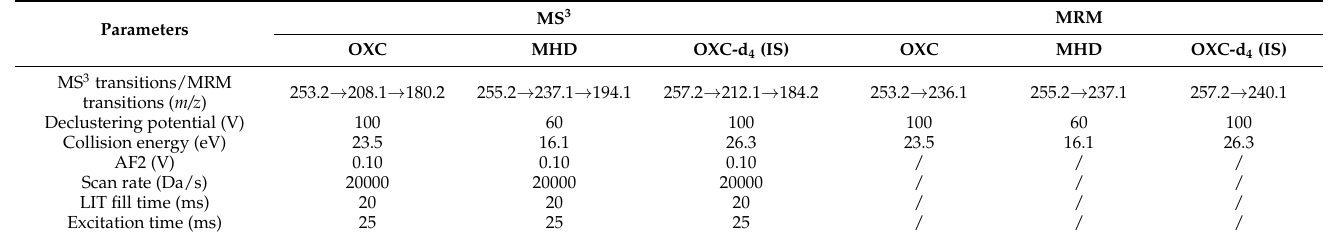
Figure 3. Product ion (MS 2 ) and second-generation product ion (MS 3 ) scans, respectively, for oxcarbazepine ( AI , AII ), 10-hydroxycarbazepine ( BI , BII ) and oxcarbazepine-d 4 ( CI , CII ). Table 4. Optimized parameters for the quantitation of oxcarbazepine (OXC) and 10-hydroxycarbazepine (MHD) using triple-stage fragmentation (MS 3 ) and multiple reaction monitoring (MRM) modes.